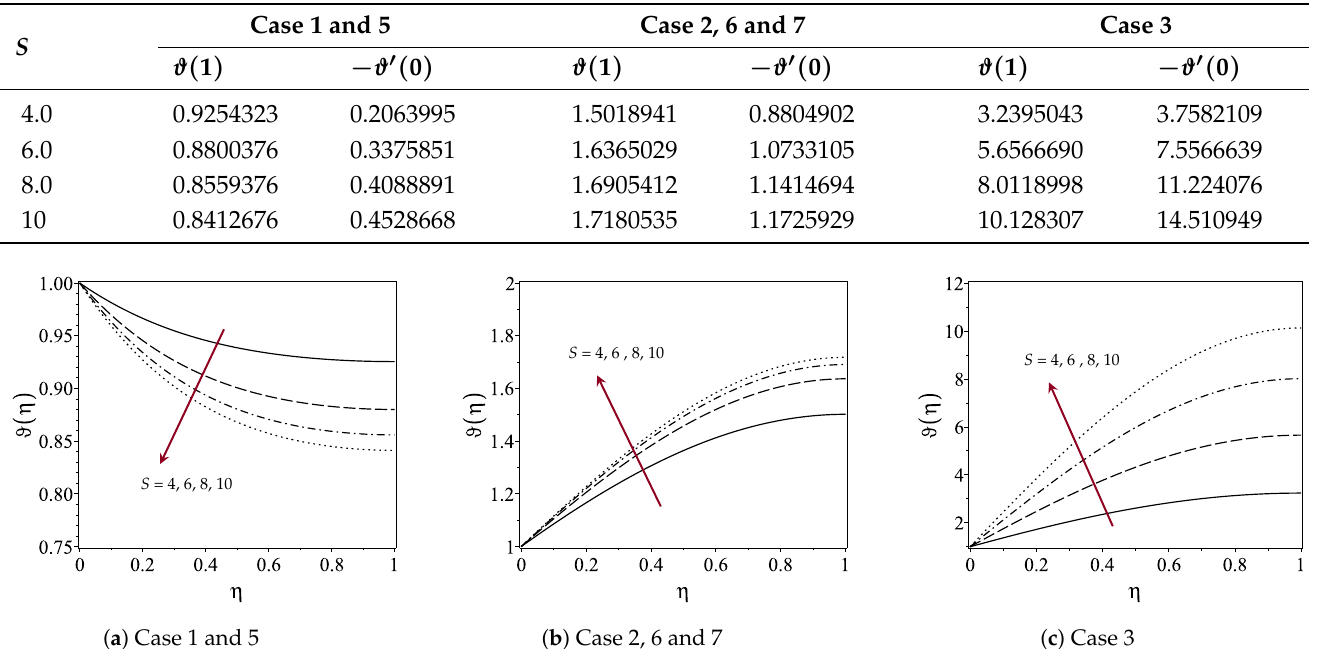
Table 7. Variation of temperature distribution with unsteadiness parameter at Pr =1 and G ∗ =1.